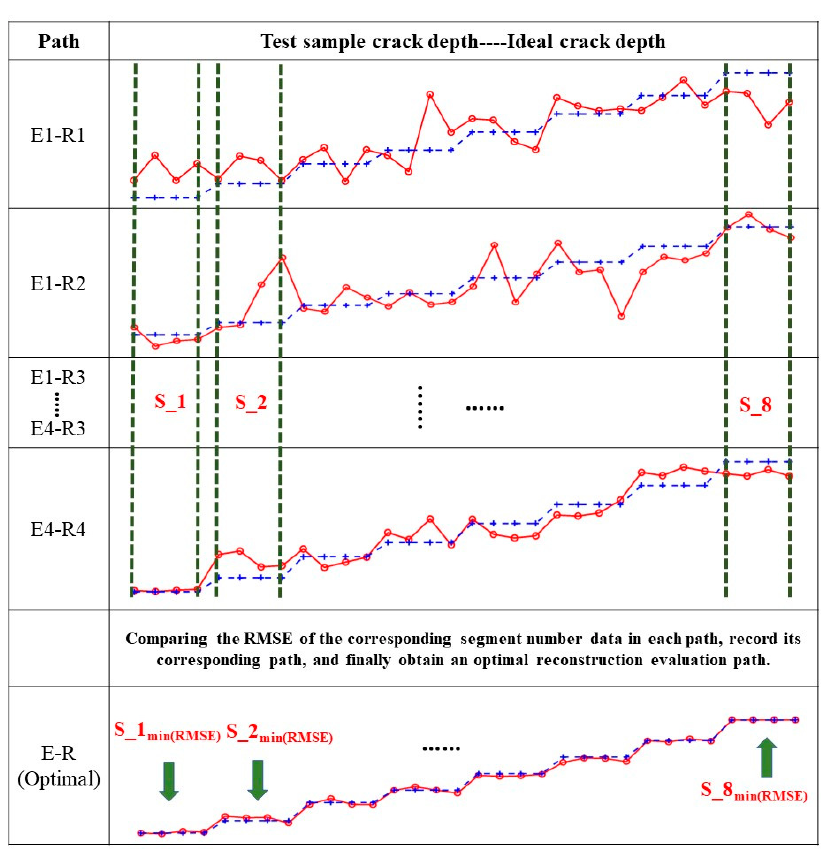
Figure 21. Guided map for the multi-path combined reconstruction model.